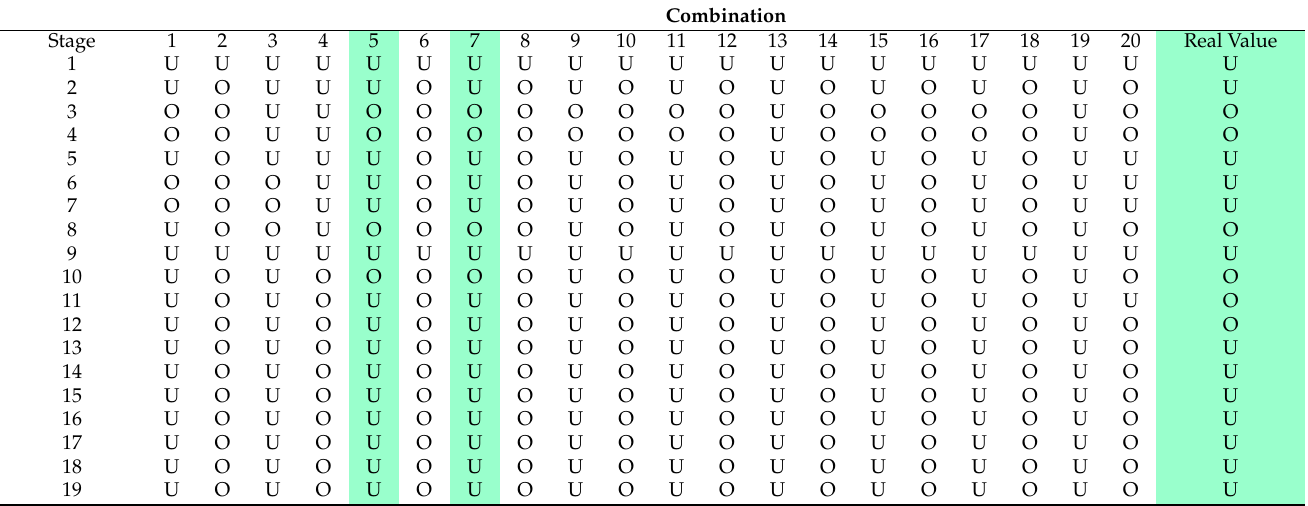
Table 6. Sensitivity Test of Potential Influence Factor Combinations.